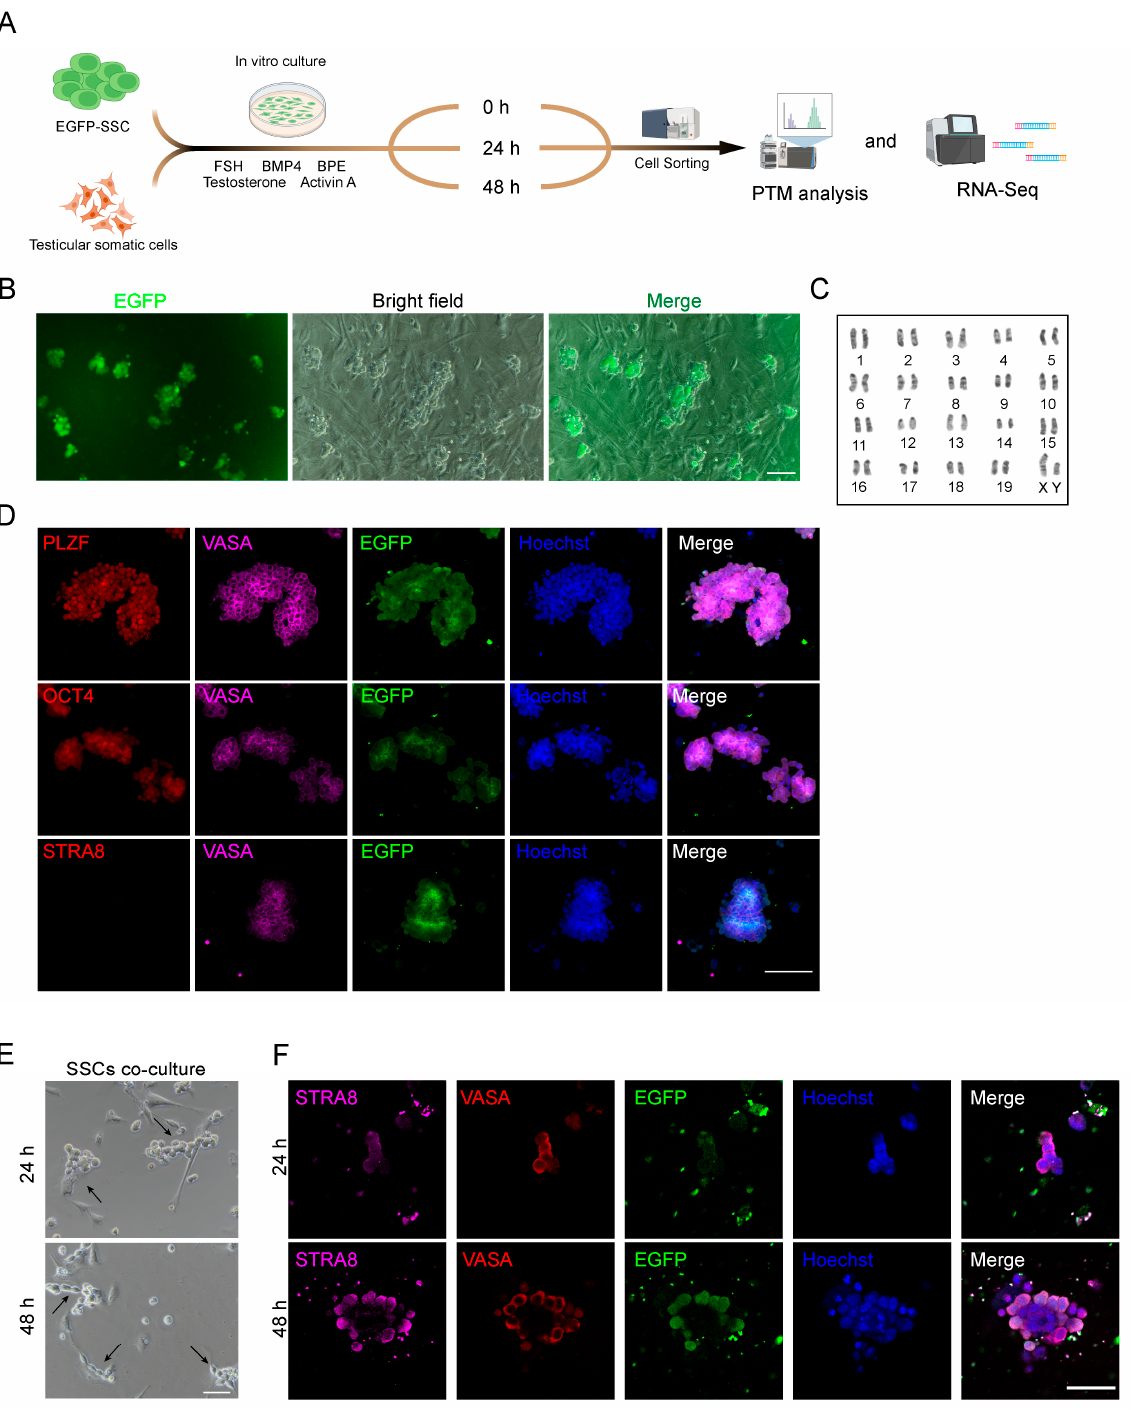
Figure 1. SSC culture and in vitro differentiation. ( A ) A schematic diagram for SSC differentiation in vitro. ( B ) In vitro fluorescence imaging of SSC expressing green fluorescence. Scale bar = 100 μ m. ( C ) Karyotype analysis of EGFP-SSC. ( D ) Immunofluorescence staining of SSC stage-specific markers (VASA, OCT4, PLZF) and staining of spermatogonia differentiation marker STRA8. Scale bar = 100 μ m. ( E ) Representative microscopic views of different stages of SSC differentiation in vitro. Scale bar = 50 μ m. Arrowheads showed differentiated SSCs. ( F ) Immunofluorescence staining of spermatogonia differentiation marker STRA8 after 24 h and 48 h differentiation. Scale bar = 100 μ m.